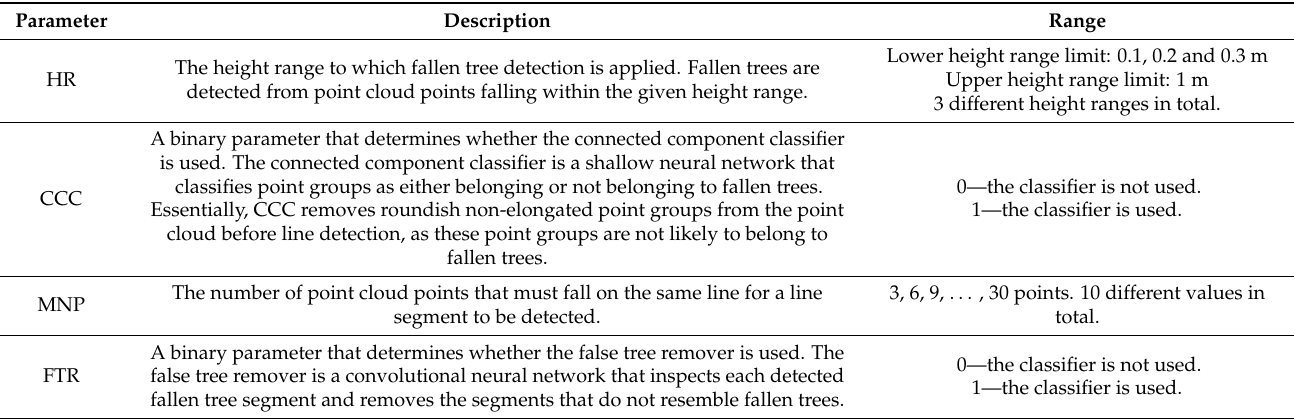
Table 2. A summary of the tested parameters: Height range (HR), connected component classifier (CCC), minimum number of points (MNP), and false tree detection (FTR) of the fallen tree detection method. Refer to Heinaro, et al. [23] for a detailed description of the